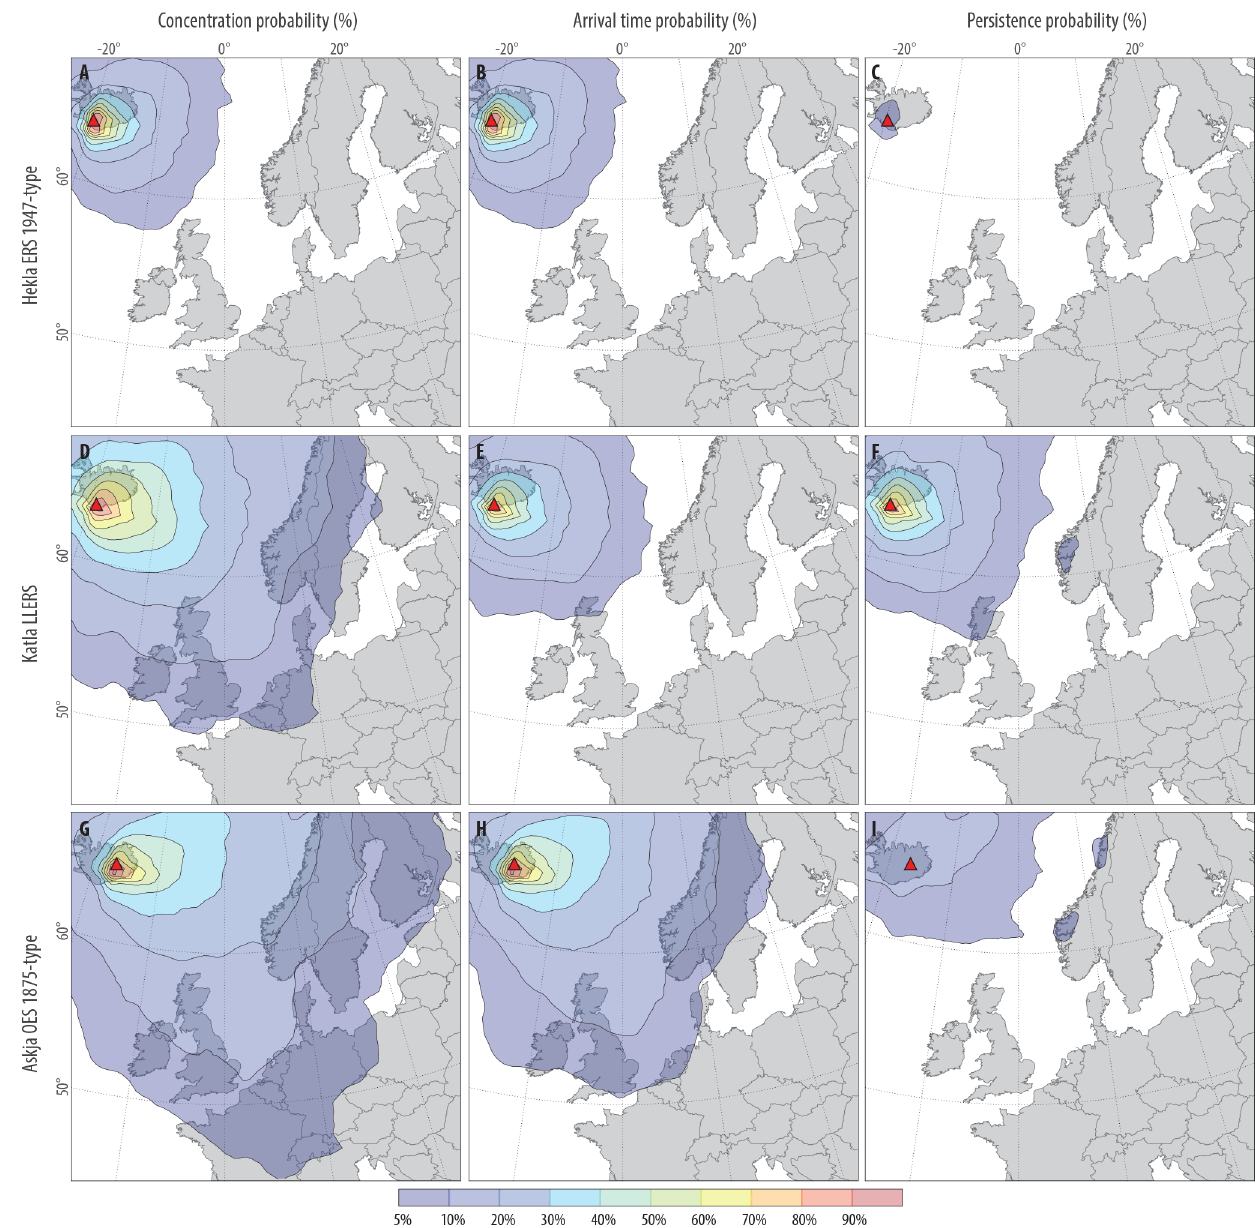
Figure 13. Atmospheric dispersion of tephra for a threshold of 2mgm − 3 for all FL for the eruption scenarios of Hekla ERS 1947-type (a, b, c) , Katla LLERS (d, e, f) and Askja OES 1875-type (g, h, i) . Maps show (a, d, g) probability maps of exceeding a concentration of 2mgm − 3 , (b, e, h) probability maps of exceeding an arrival time of 24h for a concentration of 2mgm − 3 and (c, f, i) probability maps of exceeding a persistence time of 12h for a concentration of 2mgm − 3 . Probability maps for other thresholds and separate FL are available in the